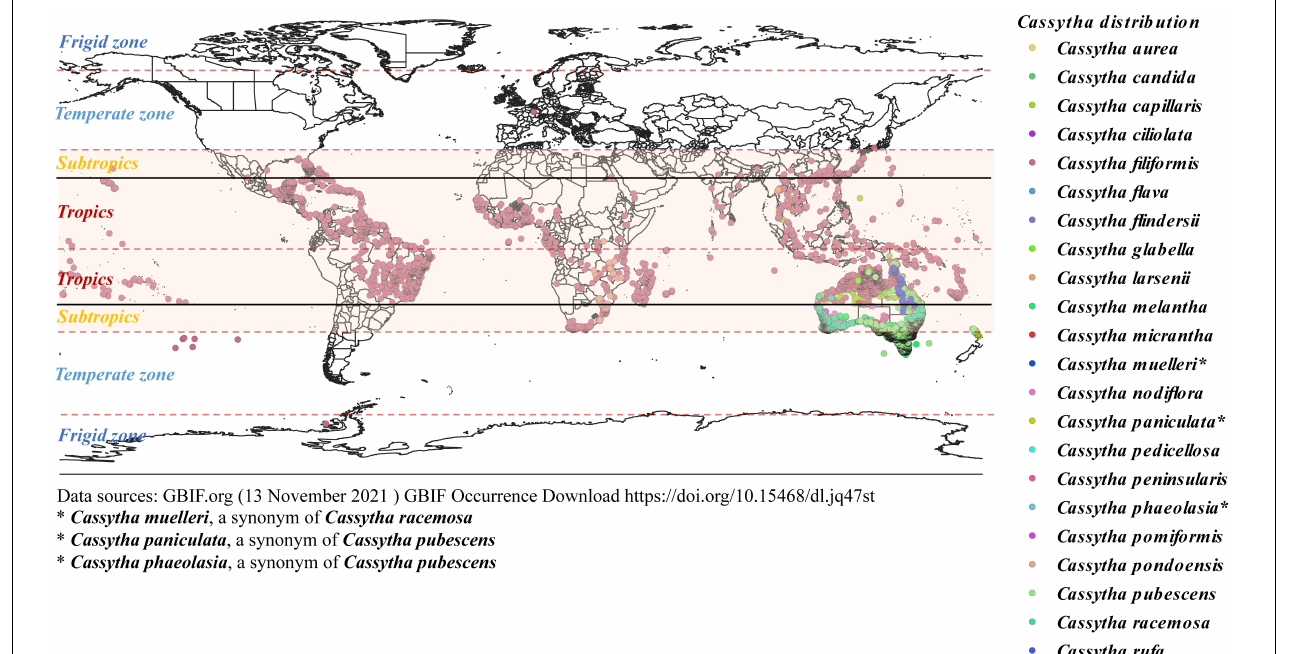
FIGURE 2 | Global distribution map of Cassytha species across climatic zones. We modified the GBIF map according to published literature and POWO to indicate the world distribution of Cassytha .